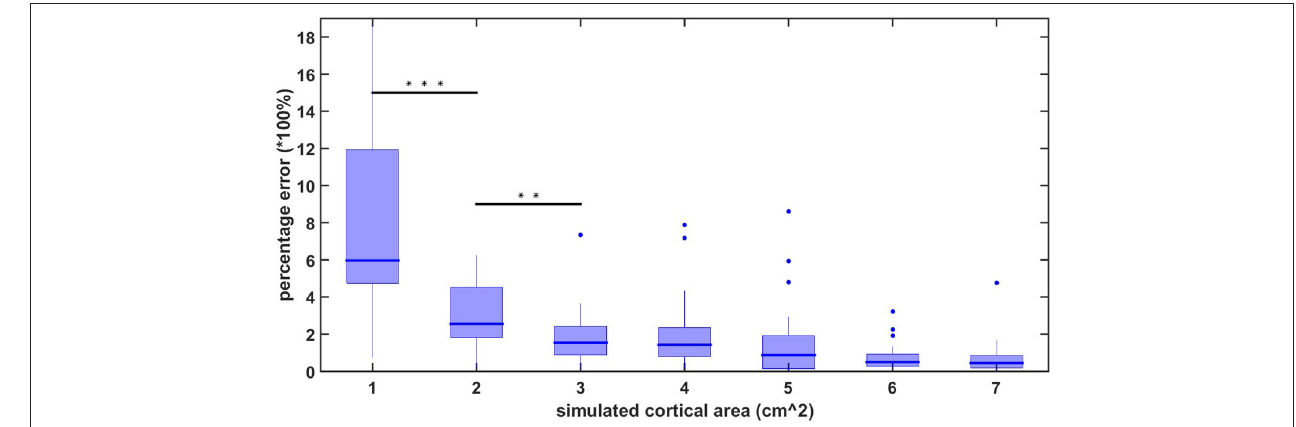
FIGURE 1 | localization percentage error for simulated source activity.